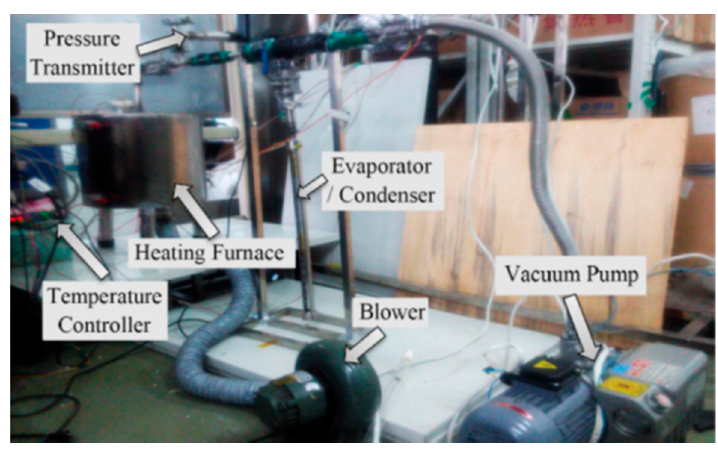
Figure 3. Photograph of adsorbent performance testing device.